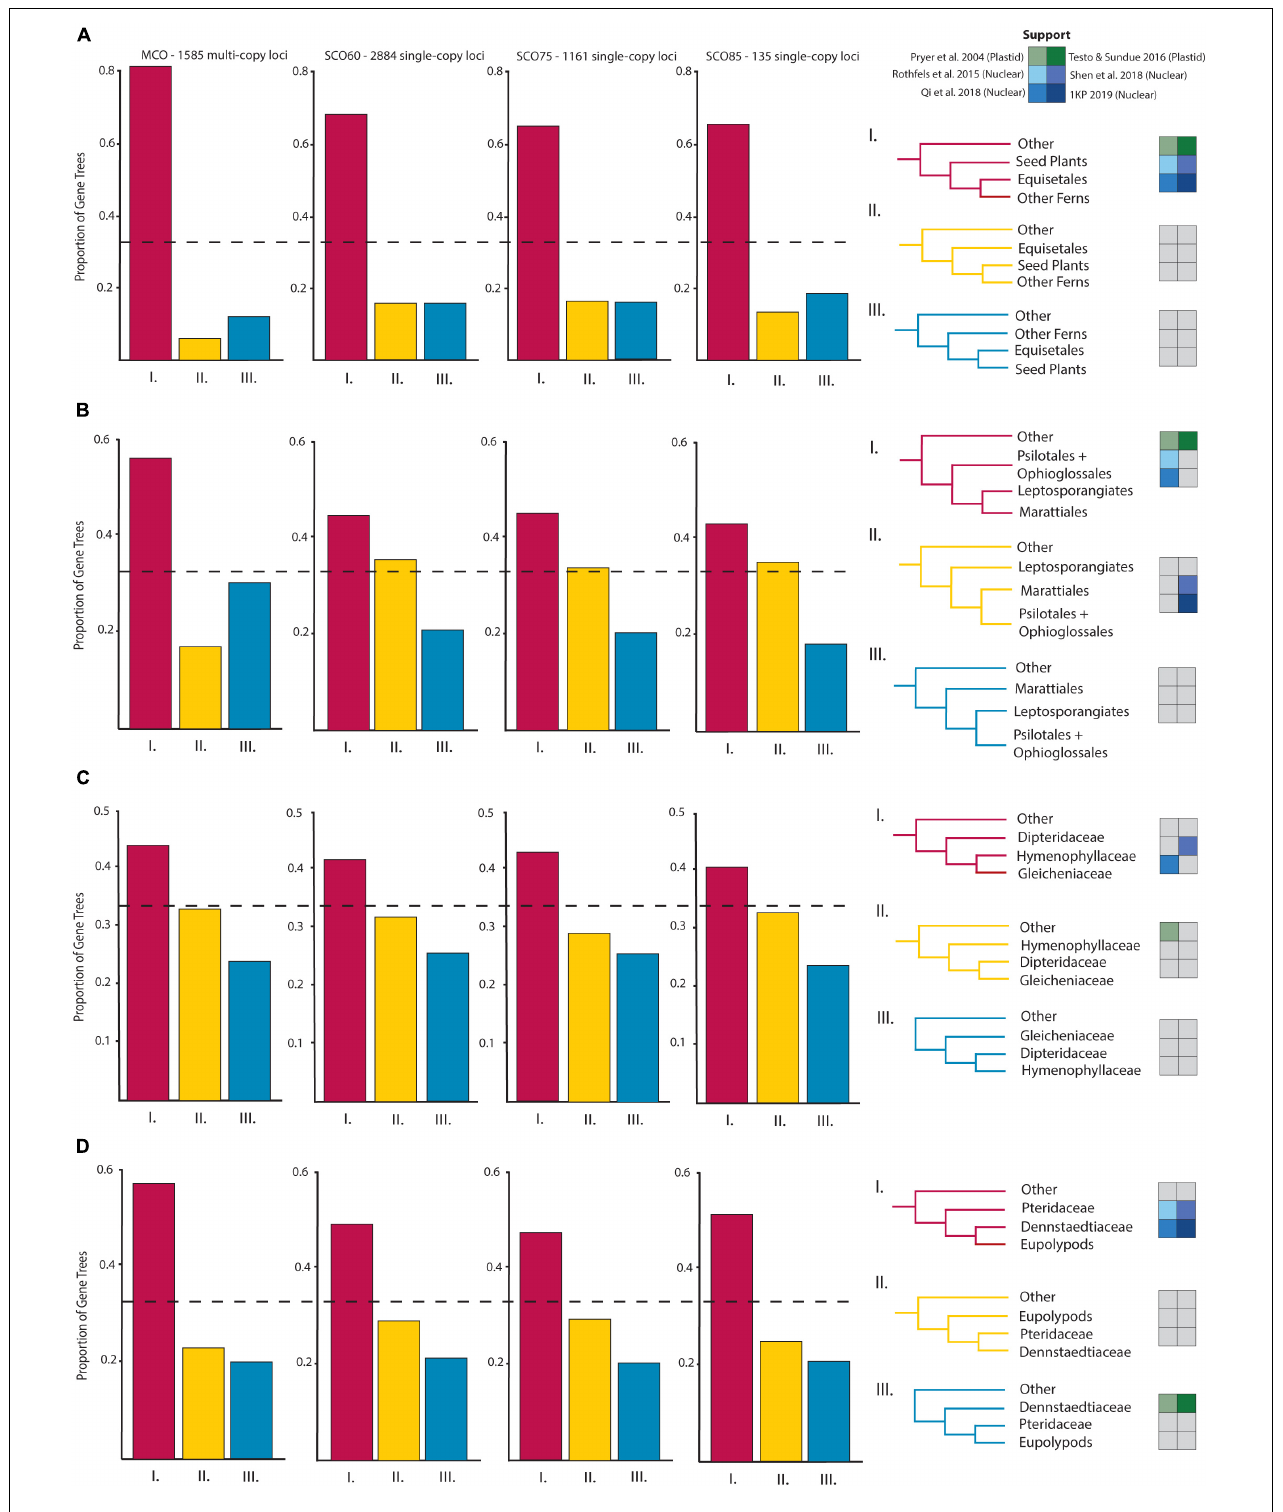
FIGURE 3 | Proportions of gene trees supporting the inferred species trees and alternative topologies for relationships of particular interest: (A) Horsetails (Equisetales) and other ferns, (B) Eusporangiate-leptosporangiate fern relationships, (C) Gleicheniales and Hymenophyllales, and (D) Pteridaceae, Dennstaedtiaceae, and the eupolypods. Topological support from select plastid (green, Pryer et al., 2004; Testo and Sundue, 2016) and nuclear (blue, Rothfels et al., 2015; Qi et al., 2018; Shen et al., 2018; One Thousand Plant Transcriptomes Initiative, 2019) studies are given beside possible topologies.